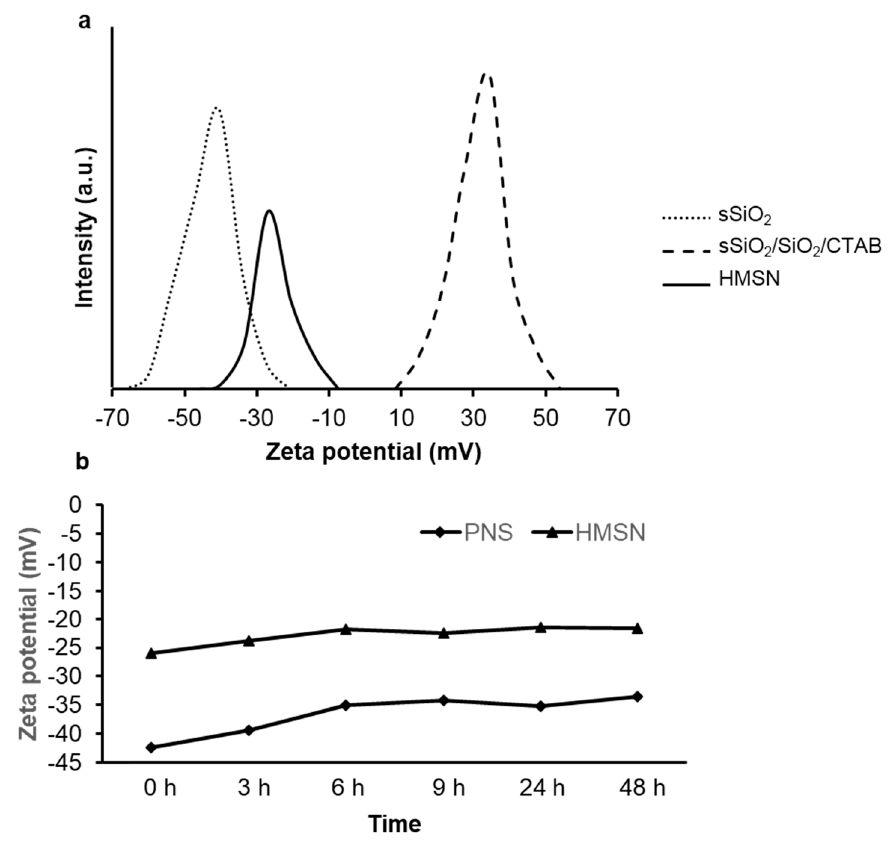
Figure 7. ( a ) Zeta potential of sSiO 2 , sSiO 2 /SiO 2 /CTAB, and HMSN; ( b ) Zeta potential of PNS and HMSN in solutions over the course of 48 h.